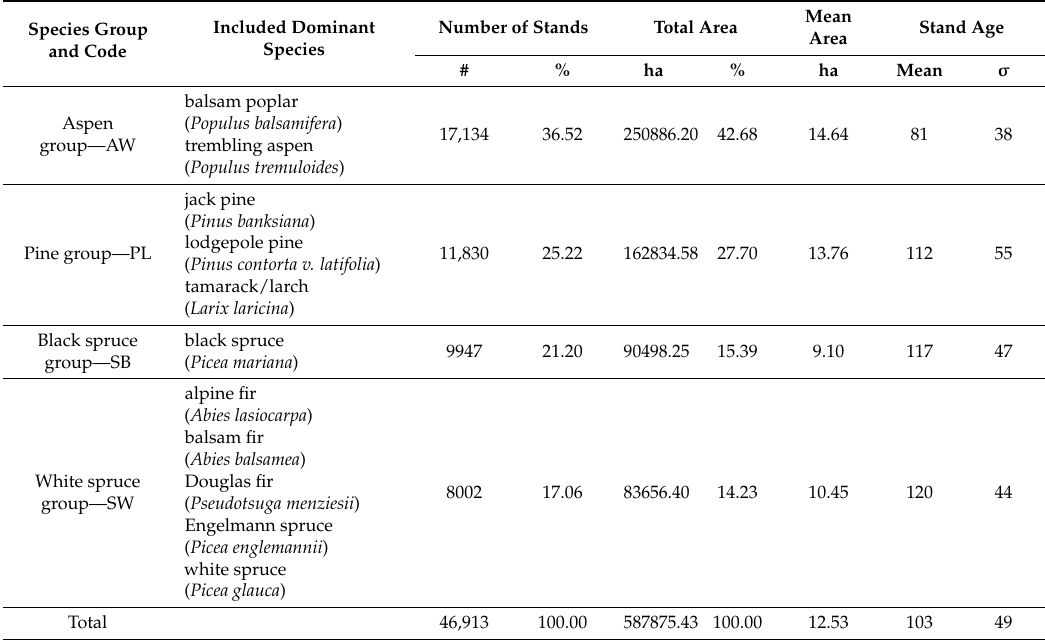
Table 1. Forest stand characteristics in the study area based on the Alberta Vegetation